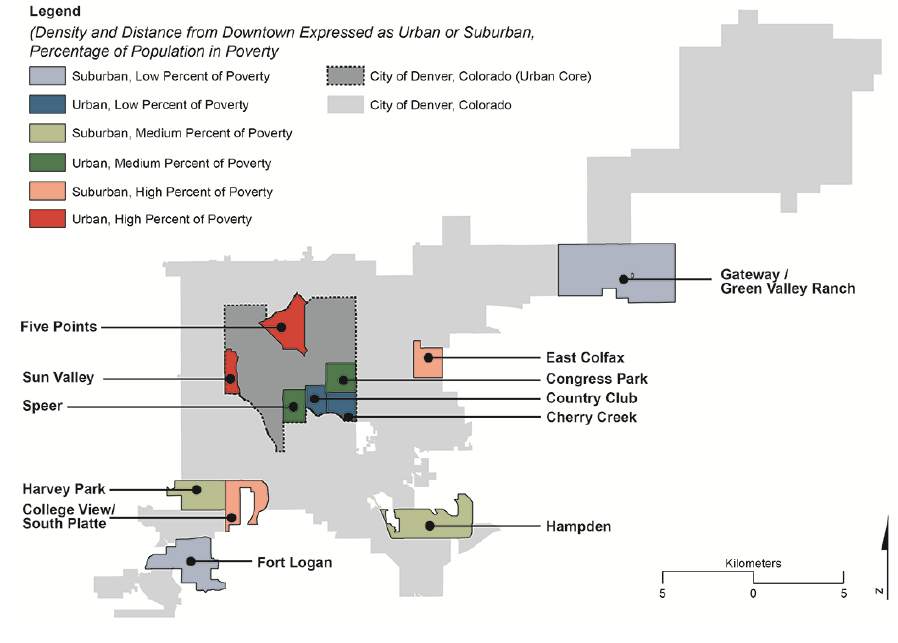
Figure 1. The 12 sampled neighborhoods in the city of Denver, classified by density and distance from downtown (suburban or urban), and